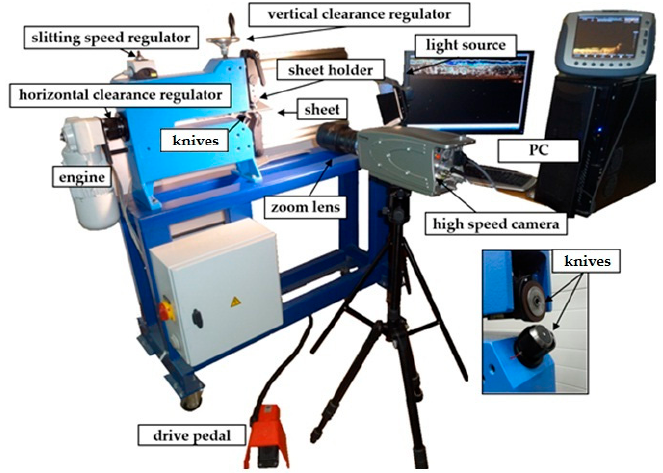
Figure 5. Experimental Setup.